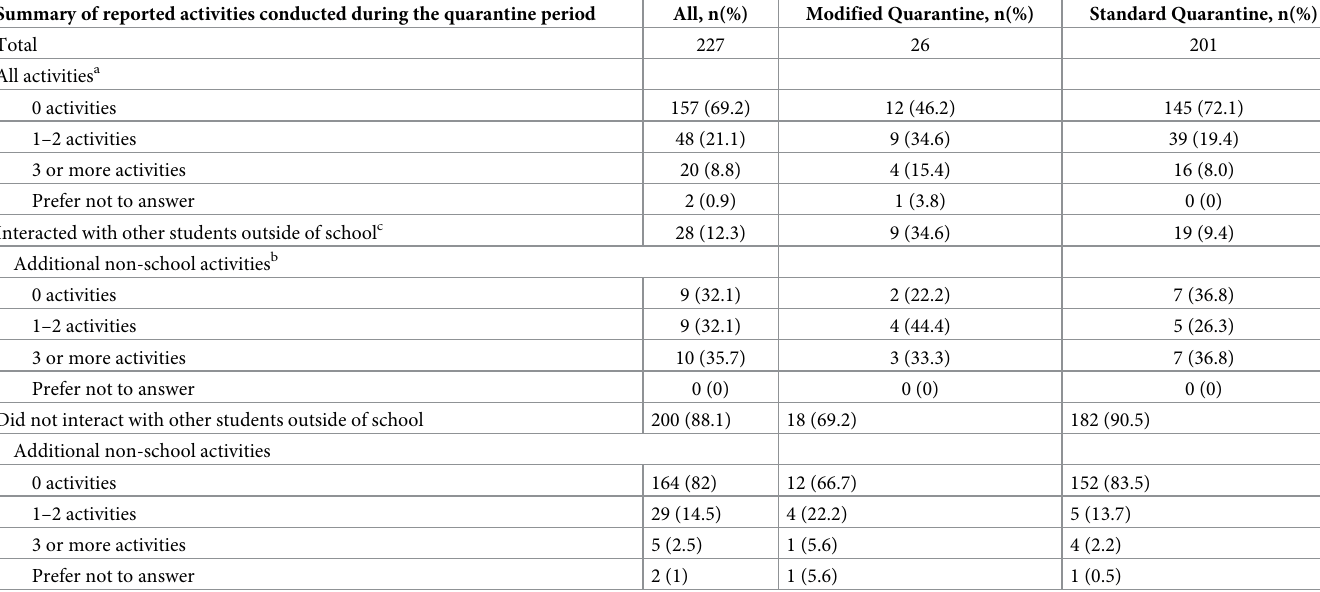
Table 3. Summary of non-school related activities reported by parents/guardian of K-12 student close contacts. Summary of reported activities conducted during the quarantine period